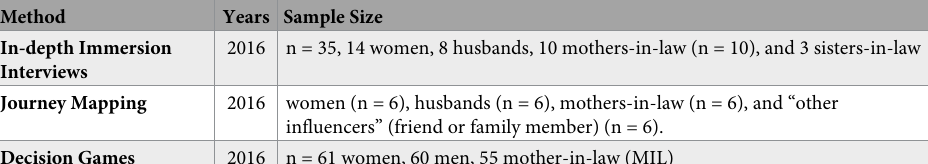
Table 2. Qualitative method sample